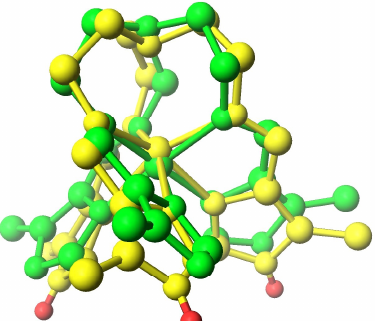
Figure 10. Superimposed structures of HS (yellow) [Fetren(5-Me-4-ImH) 3 ] 3 + and LS (green) [Fetren(5-Me-4-ImH) 3 ]. All hydrogen atoms have been removed for clarity except the three attached in the protonated form (shown in red). The structural parameters of these complexes, Fe-N imine , Fe-N imidazole , Fe-N ap , N imine –Fe-N imidazole , and C-N ap –C are as follows: HS(yellow) [Fetren(5Me-4ImH) 3 ] 3 + 2.106 Å, 2.163 Å, 2.589 Å, 75.915 ◦ , and 111.506 ◦ and LS(green) [Fetren(5Me-4Im) 3 ] 1.988 Å, 1.938 Å, 3.257 Å, 80.959 ◦ , and 119.004 ◦ .